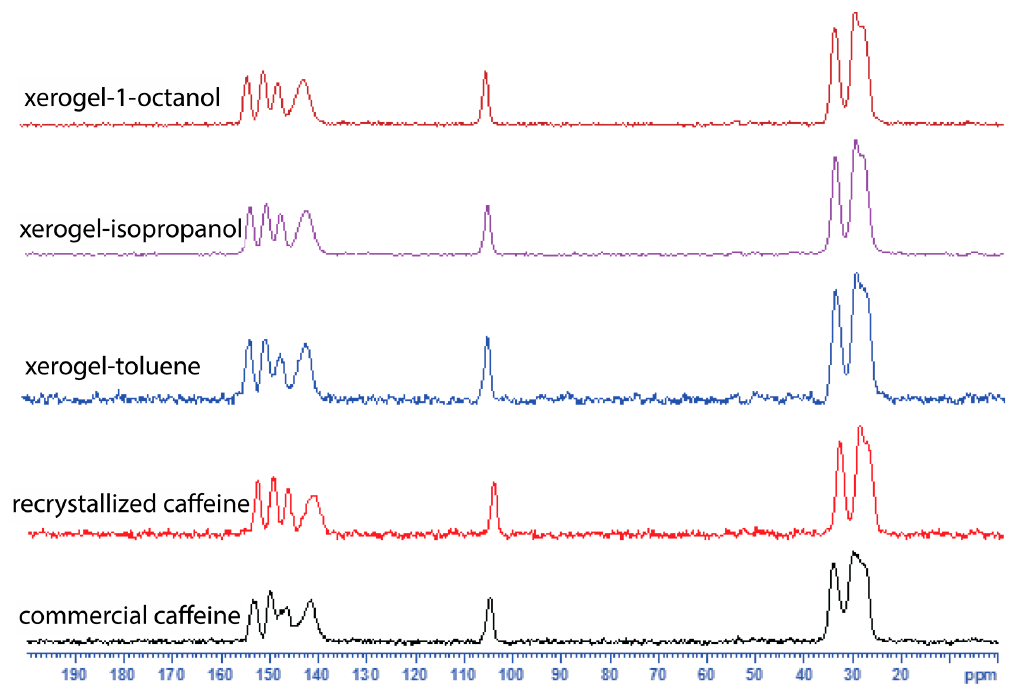
Figure 3. Solid state 13 C CPMAS NMR spectra of commercial caffeine, recrystallized form and xerogels.